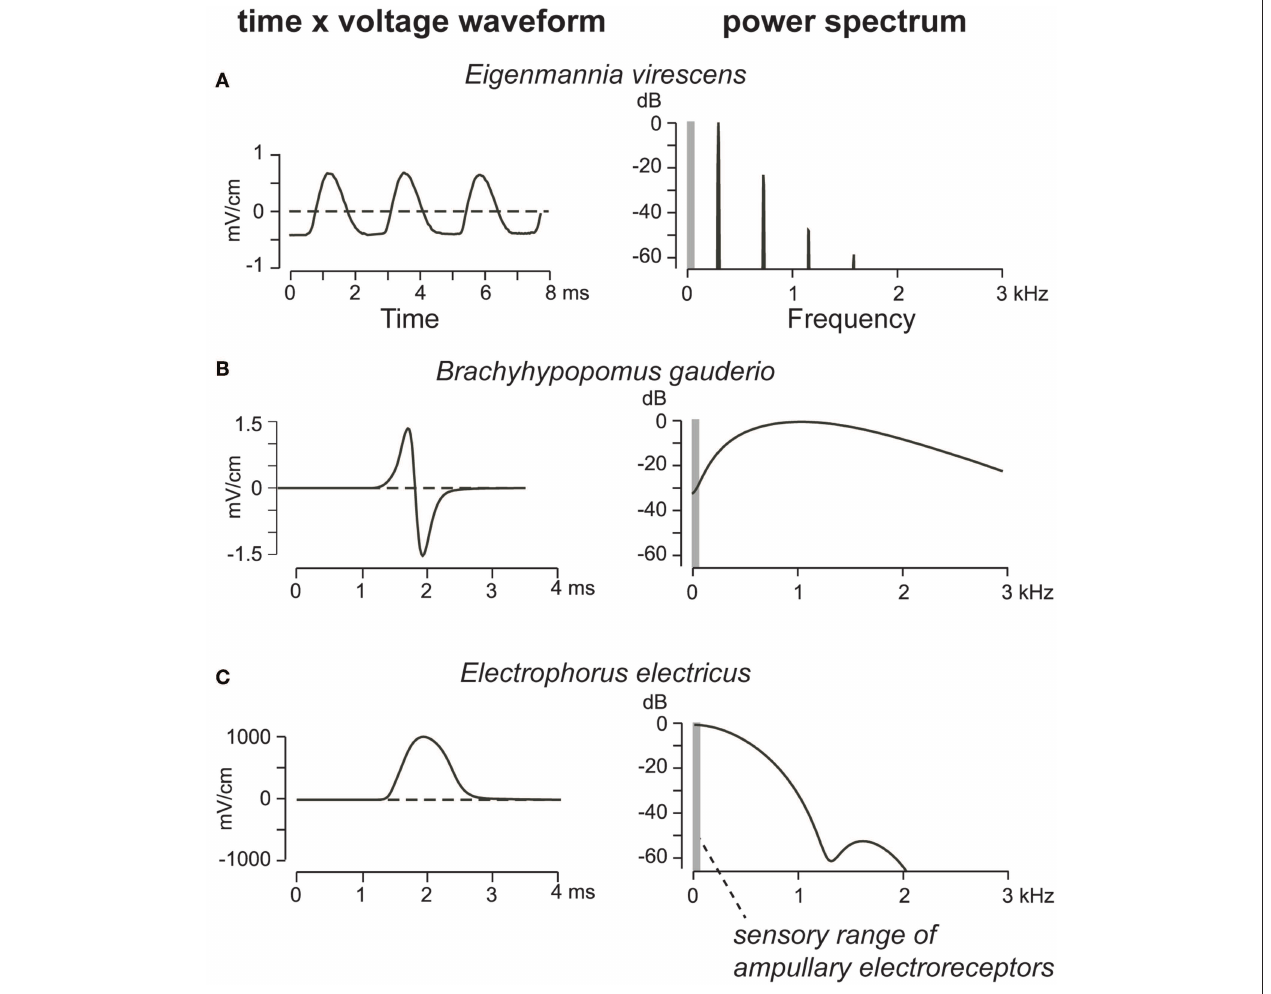
FIGURE 5 | EODs of three gymnotiform electric fish species and their corresponding power spectra. (A) Wave EOD of the Glass Knifefish, Eigenmannia virescens (Sternopygidae), is a continuous series of monophasic pulses, offset by a DC current to resemble a sine wave. The EOD is balanced around 0 Volts DC, and thus has no energy in the spectral range of ampullary electroreceptors. (B) The EOD of a female Brachyhypopomus gauderio (Hypopomidae) resembles a symmetric single-period sinusoid. Some low-frequency energy is present, but much less than (C) in the monophasic pulse EOD of the Electric Eel, Electrophorus electricus (Gymnotidae). Adapted from Stoddard and Markham (2008) with permission of the publisher.